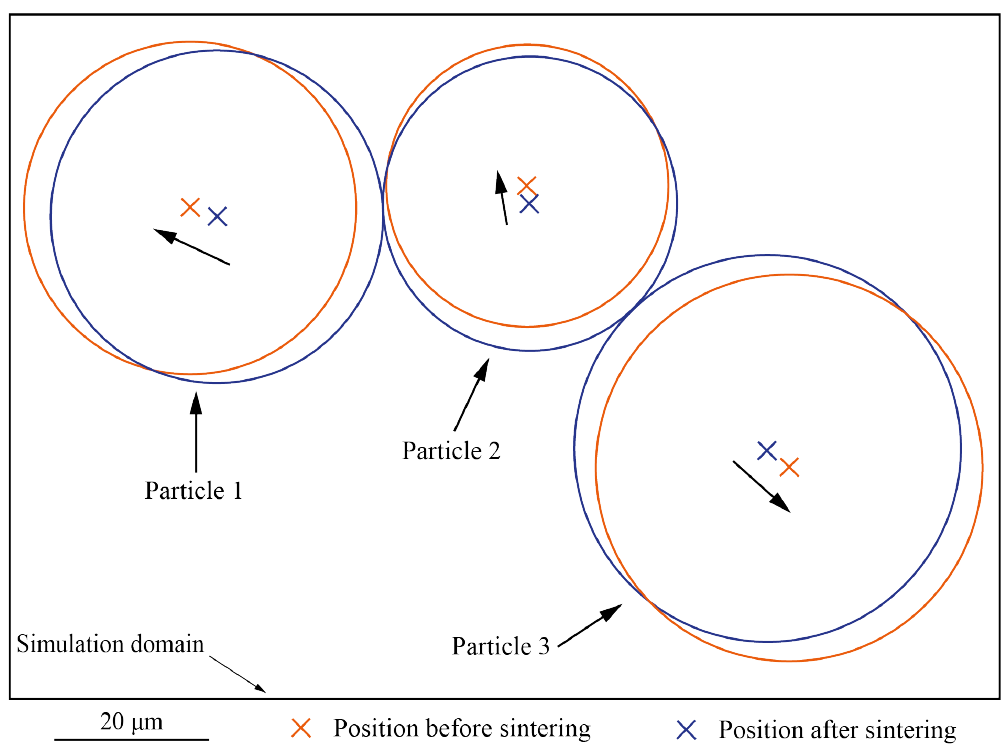
Figure 7. Translation of the particle centers from the estimated position before sintering to the position measured in Figure 5.